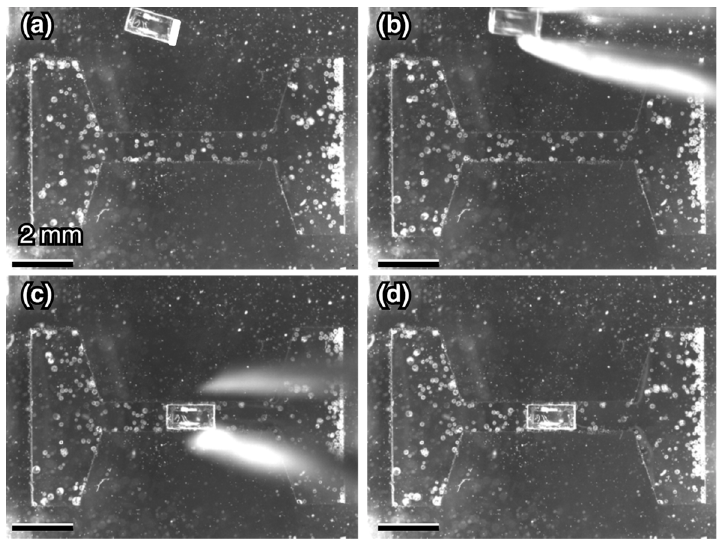
Figure 7. Fabrication results of the SU-8 blocks. ( a ) Entire view. ( b ) Yield of released blocks. Microscope images of blocks with designed values of ( c ) 500 µ m × 1000 µ m, ( d ) 750 µ m × 1500 µ m, ( e ) 1000 µ m × 2000 µ m, and ( f ) 1250 µ m × 2500 µ m (Width × Length). ( g ) Widths and ( h ) lengths of SU-8 blocks versus designed values. Micromachines 2018 , 9 , x FOR PEER REVIEW